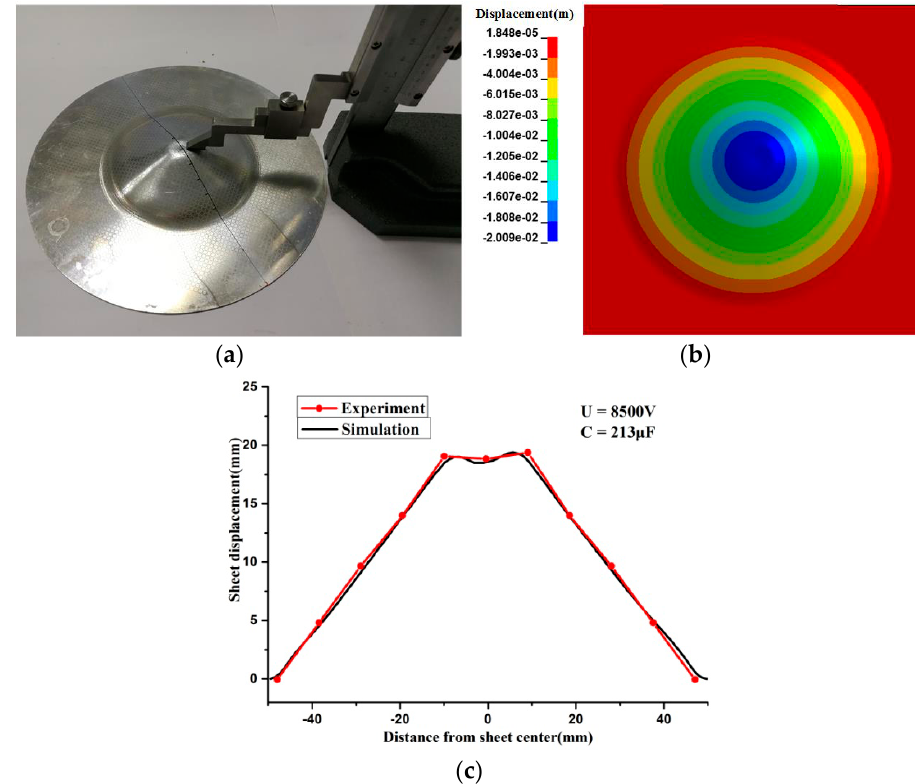
Figure 15. The deformation height and shape profiles of high-speed impaction at a discharge voltage of 8.5 kV: ( a ) experiment result; ( b ) simulation result; and ( c ) profiles comparison between the experimental and simulated results along the central plane.